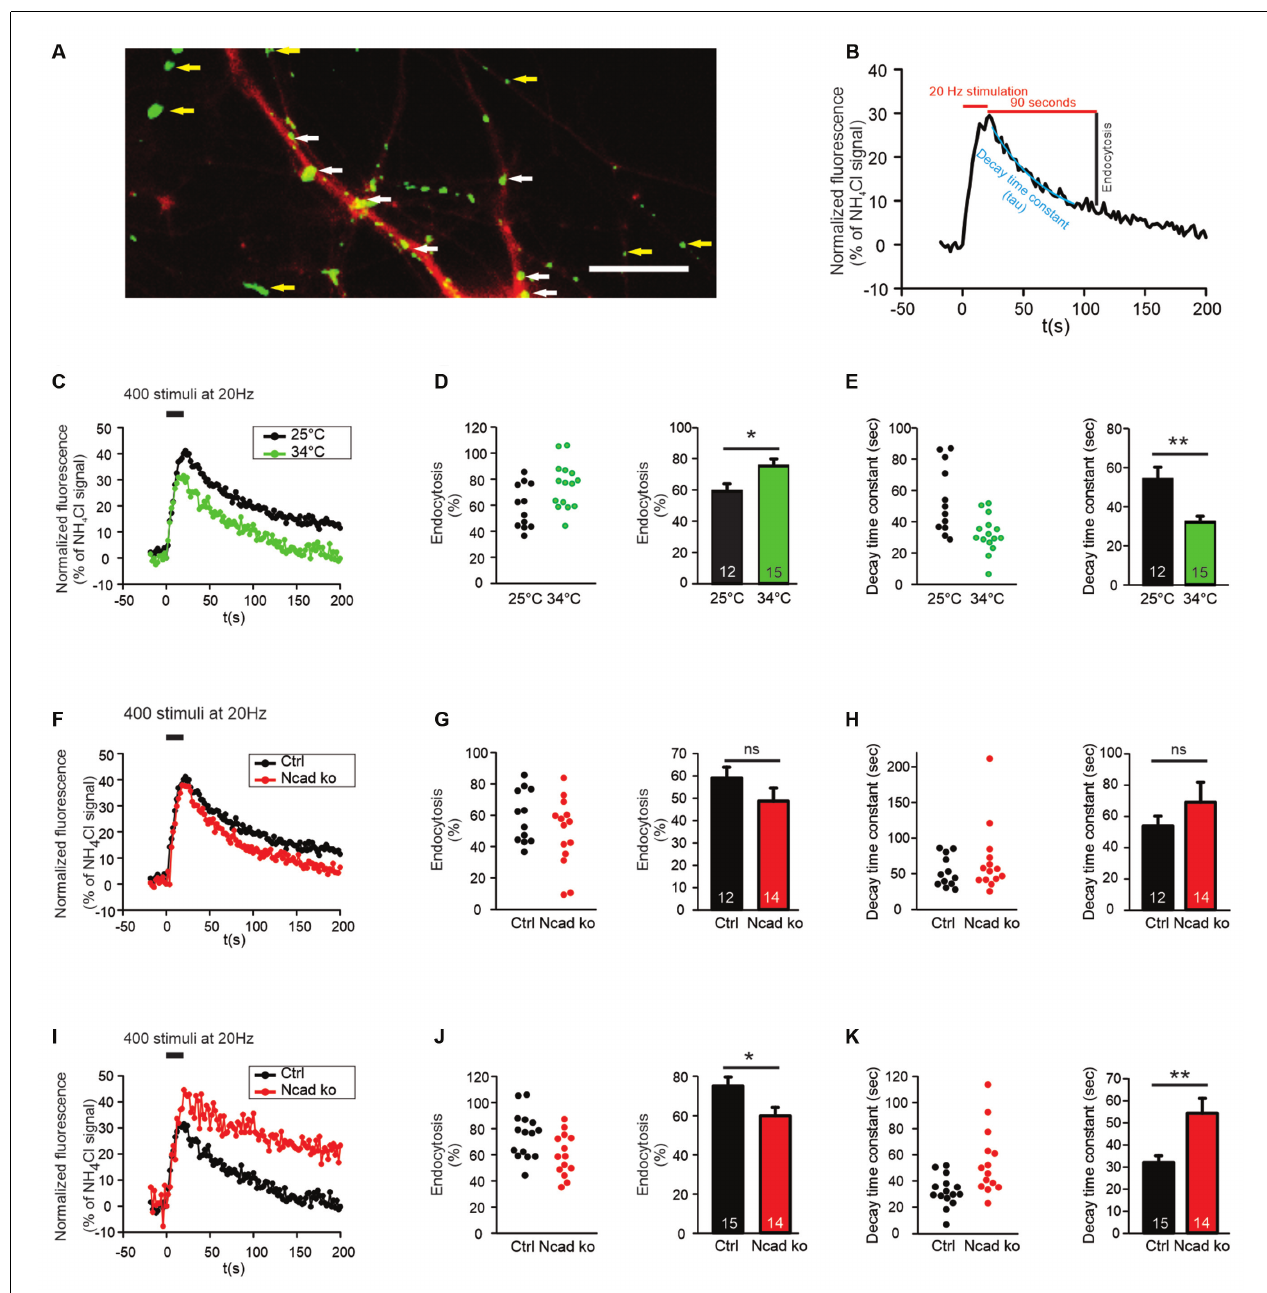
FIGURE 1 | N-cadherin knockout resulted in impaired synaptic vesicle endocytosis at near physiological temperature (34 ◦ C) at autapses. (A) Example overlay image of cultured cortical neuron processes showing the expression of DsRed2 (transfection marker, red) and the NH 4 Cl-induced SypHy fluorescence (green) at 14–15 DIV. White arrows indicate autapses, and yellow arrows indicate axonal release sites. Scale bar: 10 µ m. (B) Scheme of quantification of vesicle endocytosis from a SypHy fluorescence signal. Monoexponential fitting (blue) was used to determine decay time constants. (C–E) Increasing temperature from room (25 ◦ C) to near physiological (34 ◦ C) temperature enhanced synaptic vesicle endocytosis at autapses. n = 12 (25 ◦ C)/15 (34 ◦ C) cells, total SypHy puncta analyzed were 267/203. (C) Example time courses of mean SypHy fluorescence intensities (all puncta per cell averaged, normalized to NH 4 Cl signal) in response to 400 stimuli at 20 Hz at room temperature (25 ◦ C, black) and at 34 ◦ C (green). (D) Quantitative analysis of endocytosis at 90 s after the end of stimulation (SypHy signal loss as % of maximal SypHy signal) in individual neurons ( left ), and means ± SEM at room and near physiological temperature ( right ). P = 0.023. (E) Quantification of SypHy signal decay time constant (tau, monoexponential fit) in individual neurons ( left ), and means ± SEM at room and near physiological temperature ( right ). P = 0.003. (F–H) Conditional knockout of N-cadherin did not significantly affect synaptic vesicle endocytosis at room temperature (25 ◦ C). n = 12 (control)/14 (knockout) cells, total SypHy puncta analyzed were 267/268. (F) Example time courses of mean SypHy fluorescence intensities (all puncta per cell averaged, normalized to NH 4 Cl signal) for control (co-expressing DsRed2 + SypHy; black) and N-cadherin knockout (co-expressing DsRed2 + SypHy + CreEGFP; red) neurons at 25 ◦